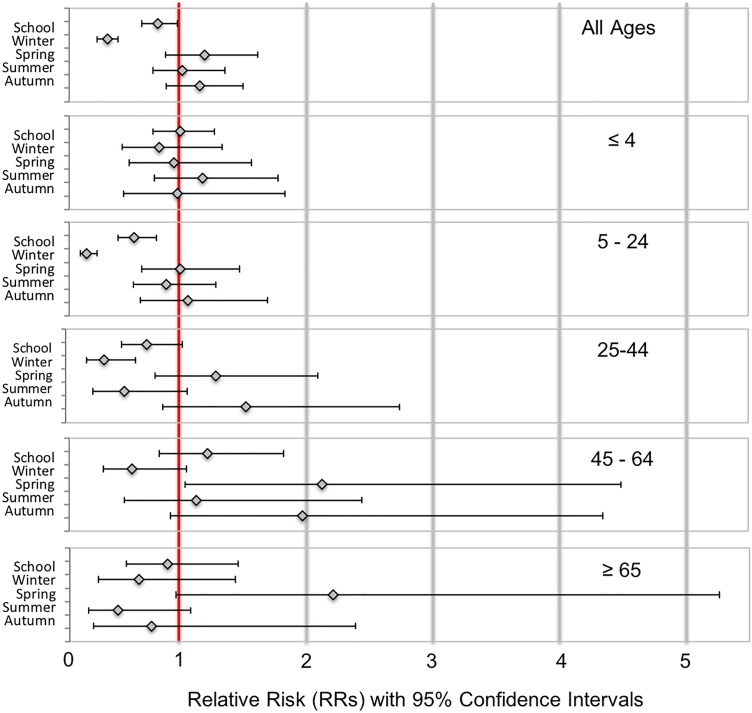
Estimates of relative risk (RR) with 95% confidence intervals for all university school holiday weeks (School) and individual school holiday weeks (Winter, Spring, Summer, Autumn) based on Model 3.